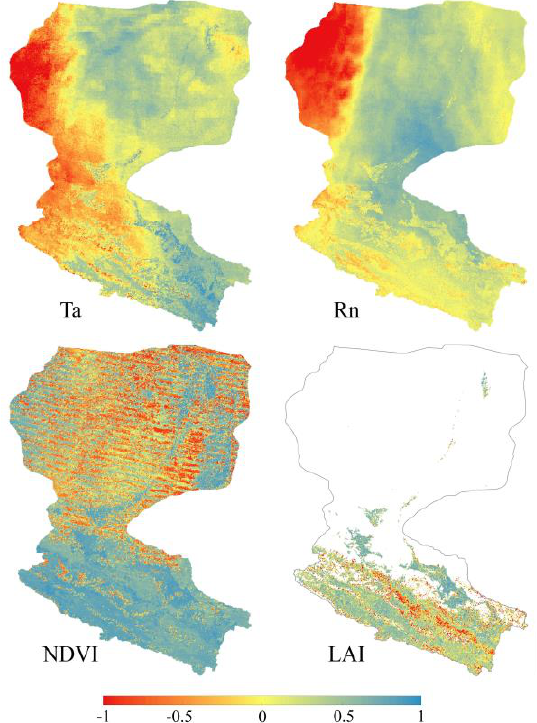
Figure 8. Spatial distribution of the PPMCC between environmental variables and latent heat flux.